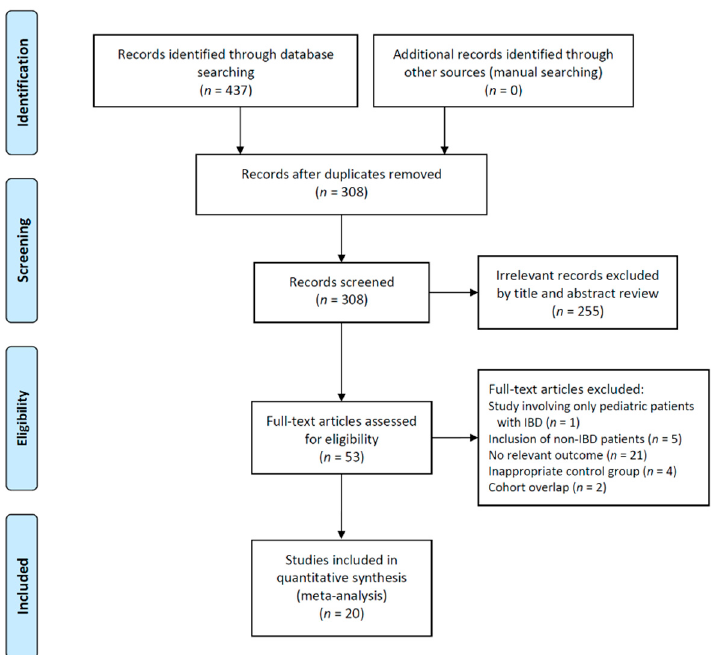
Figure 1. Study flow diagram. IBD—inflammatory bowel disease.